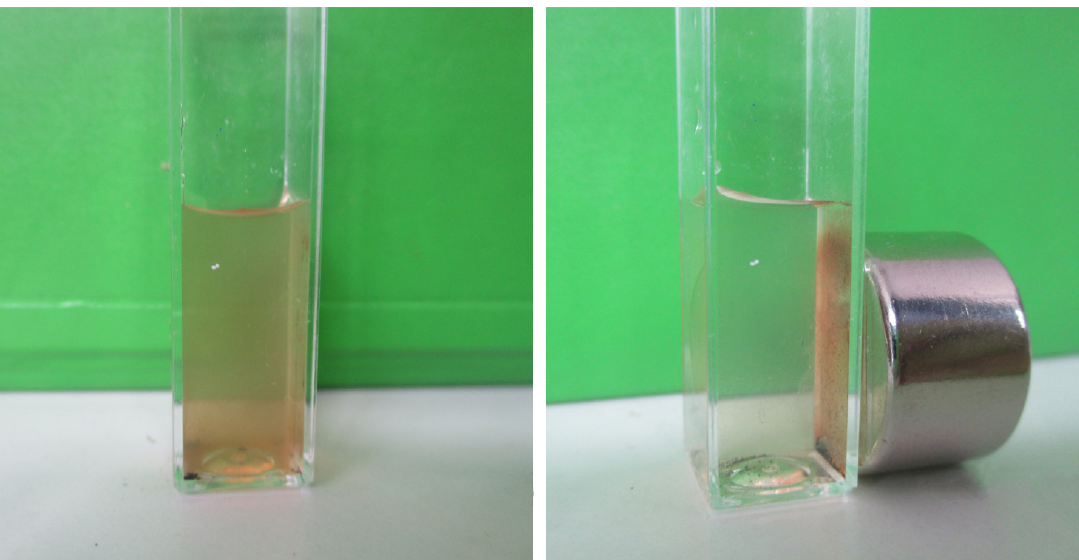
Figure 6. Magnetic separation of fourlayered core/shell particles (sample CF4-11) from aqueous solution by a N45NdFeB